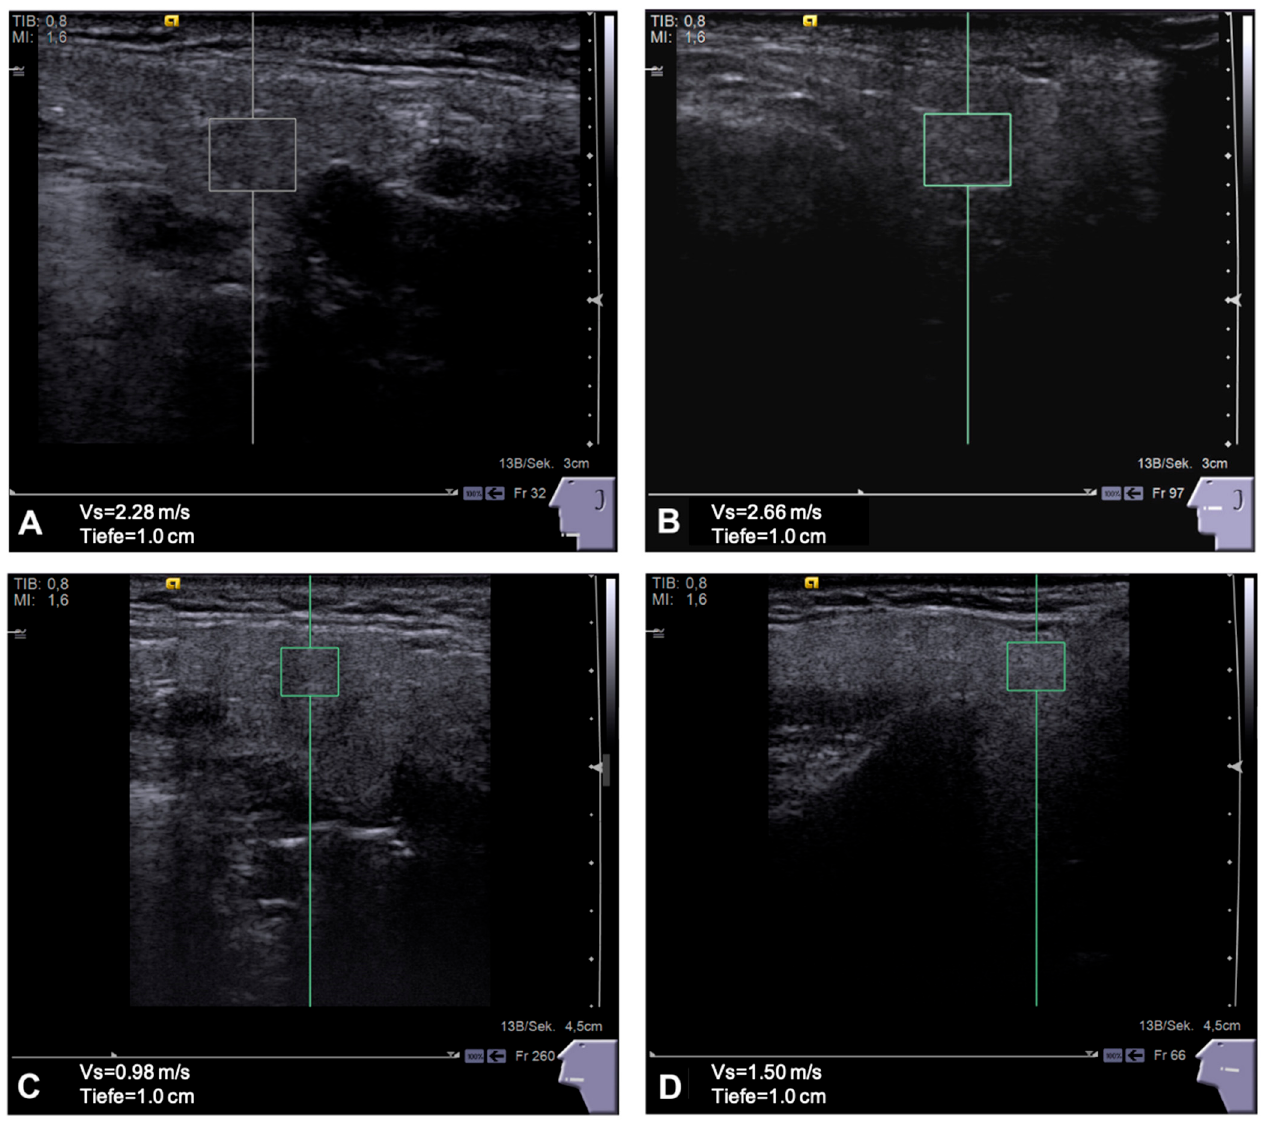
Figure 2. Point shear wave elastography (pSWE) images and corresponding shear wave velocities of a patients ( A ) GSM 2.28 m/s and ( B ) PG 2.66 m/s are shown. Glands are notably smaller and more fibrous after surgery and adjuvant C/RT. The respective healthy glands and values of a control person are shown in ( C ) GSM 0.98 m/s and ( D ) PG 1.50 m/s.